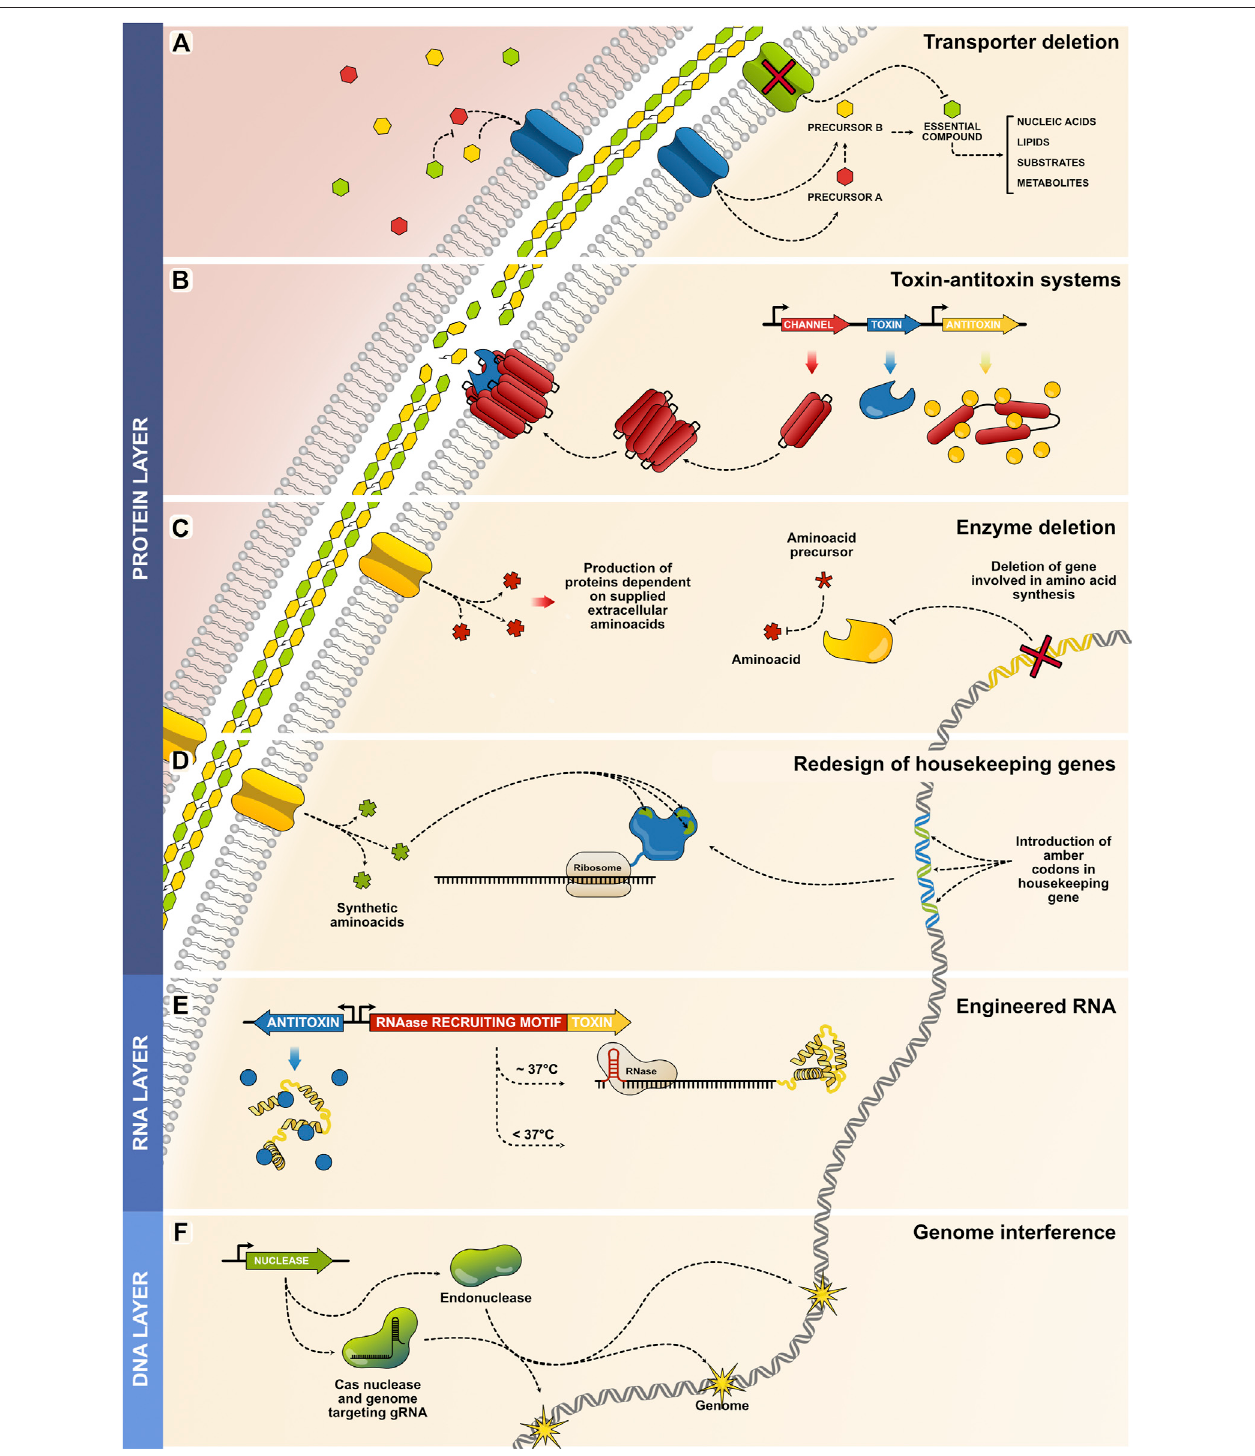
FIGURE 2 | Strategies for modulating microbial propagation across the protein, RNA, and DNA layers. (A) Auxotrophy by transporter deletion is achieved by deletingageneencodingamembranetransporterrequired toimportanessentialcompound (greenchanneland greenhexagon)required formaintainingcentralcellular processes.Thus,strictsupplementation ofprecursors (redandyellow hexagons)isneededtoensurecellsurvival. (B) Toxin-antitoxin systemselicitcelldeathviavarious mechanisms.Acommonmechanismisthedegradationofthebacterialcellularwallbycatalyticenzymes(bluetoxin),whichcompromisesitsstructuralintegrityand elicitscellularbursting.Accessoryelementssuchasmembranechannelscanbeaddedtofacilitatetheactivityofthetoxinprotein.Ultimately,theantitoxinisconstitutively